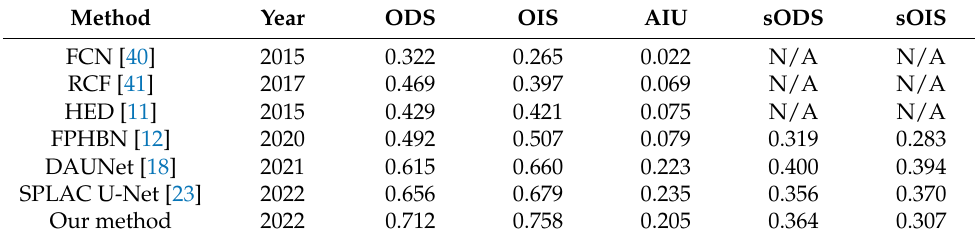
Table 5. Segmentation performance comparison results on AEL dataset.